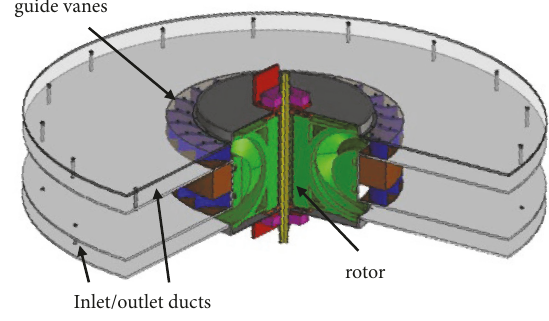
Figure 7: Biradial